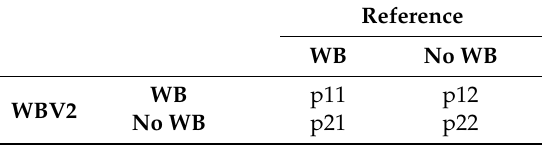
Table C1. Confusion matrix frim which the Commission and omission errors are